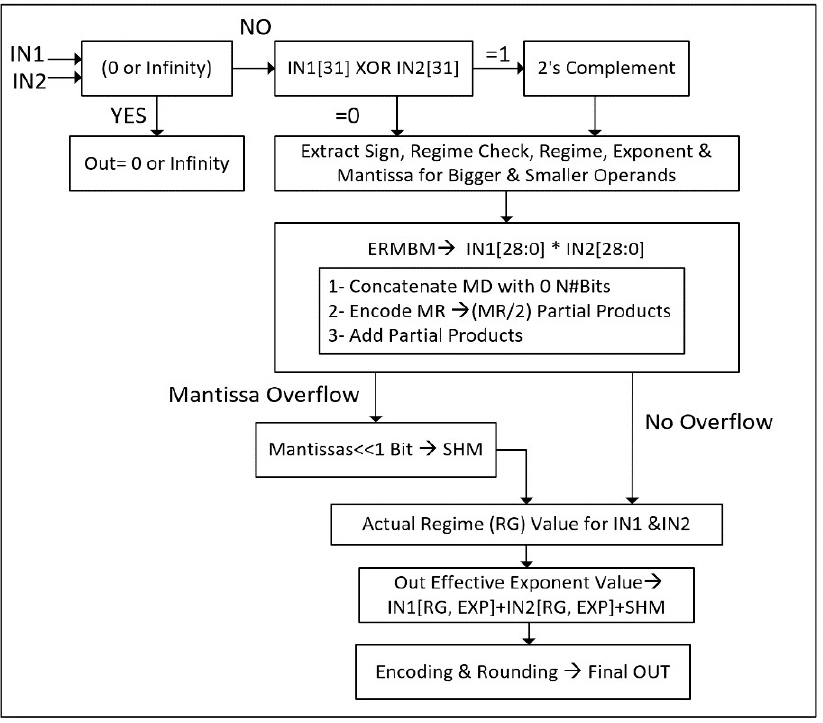
Figure 9. Block diagram of POSIT ERMBM.